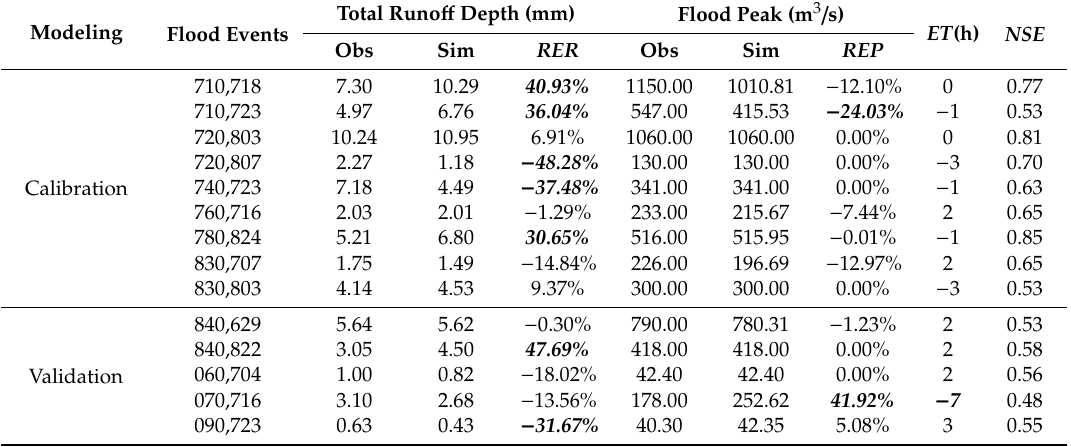
Table 3. Observation, simulation and performance evaluation measures by SVHM model in Chutoulang